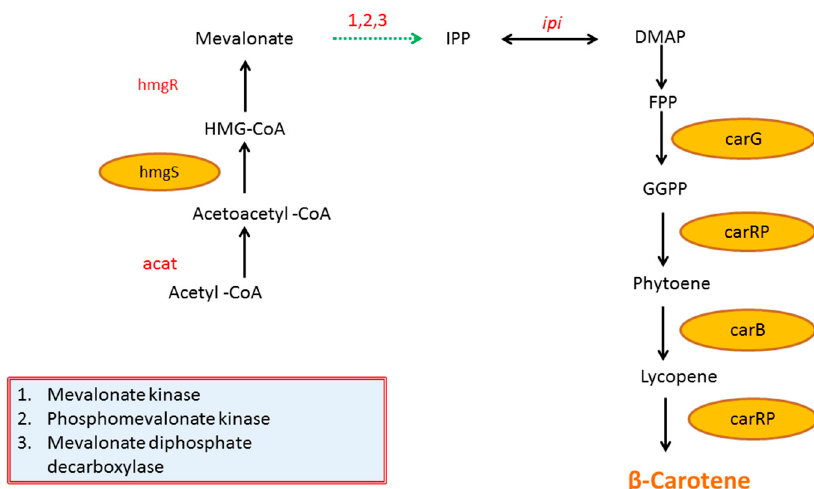
Figure 1. Metabolic pathway of β -carotene biosynthesis in M. circinelloides . Dashed lines represent multiple steps. HMG-CoA-3-hydroxy-3-methylglutaryl-CoA; IPP-isopentenyl pyrophosphate; DMAP-dimethylallyl pyrophosphate; FPP-farnesyl pyrophosphate; GGPP-geranylgeranyl pyrophosphate. M. circinelloides genes investigated in present study are highlighted in yellow: acat -Acetyl-CoA thiolase; hmgS -HMG-CoA synthase; ip i-IPP isomerase; carG -GGPP synthase; carRP -phytoene synthase / lycopene cyclase; carB -phytoene desaturase [2].